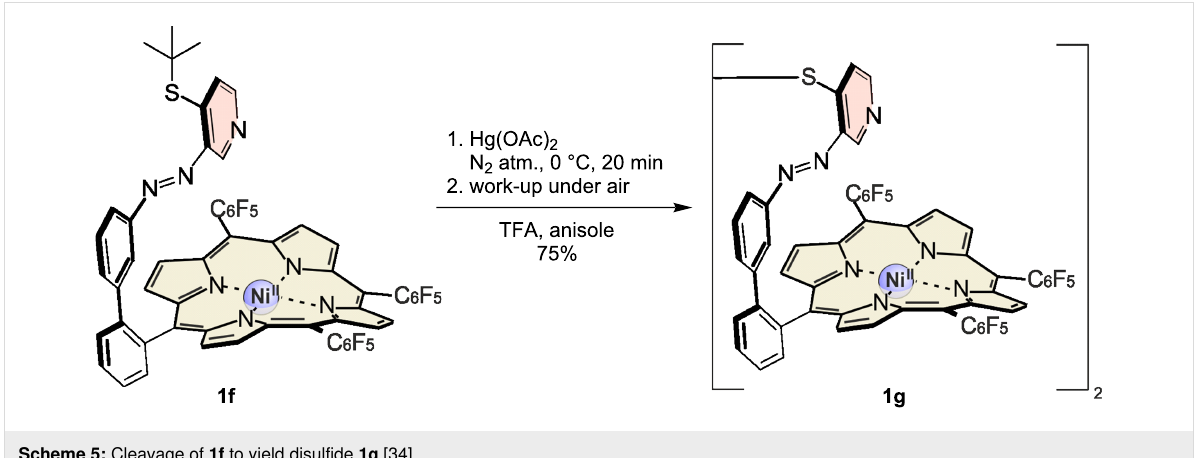
Table 1: Switching states and switching efficiencies ( Δ ) of record player molecules 1a–j in the PSS at 505 nm and 435 nm in acetone as a non-coor- dinating solvent. % cis- para and % cis- dia are defined as the proportion of the cis isomer in the paramagnetic and diamagnetic state, and % trans is the total proportion of the trans isomer, which is assumed to be completely diamagnetic at low concentrations. R